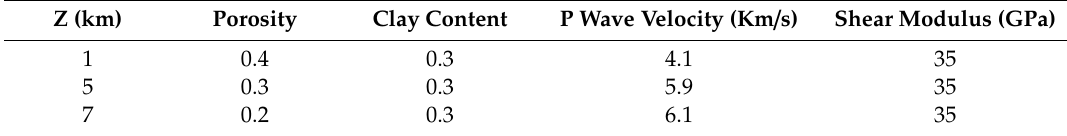
Table 1. Details regarding the input parameters in the rock modeling.